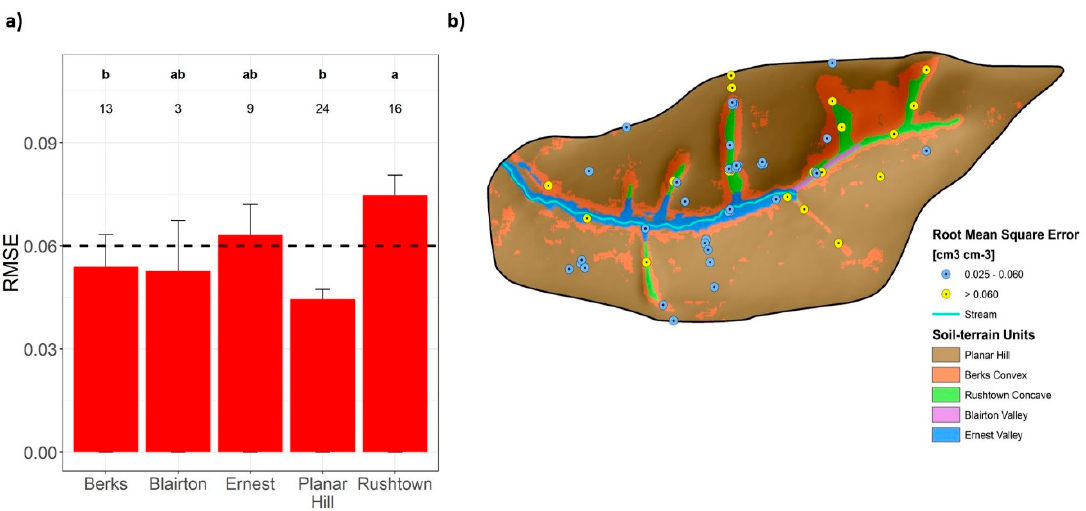
Figure 4. ( a ) Bar plots of mean root mean square error (RMSE; cm 3 cm − 3 ) of the spatial Shale Hills SMAR model grouped by soil–terrain unit. Hinges above the bars indicate standard error for each group. Letters indicate statistically significant differences ( p < 0.05) between soil–terrain groupings of RMSE that are based upon a post-hoc, Dunn’s pairwise comparisons test. Numbers underneath the letter qualifiers indicate the sample size of each group. The dashed line represents NASA’s quality benchmark for soil moisture predictions using satellite observations. ( b ) Map of the root mean square error (RMSE) at each manual time domain reflectometry (TDR) monitoring location resulting from the spatial SMAR validation analysis.